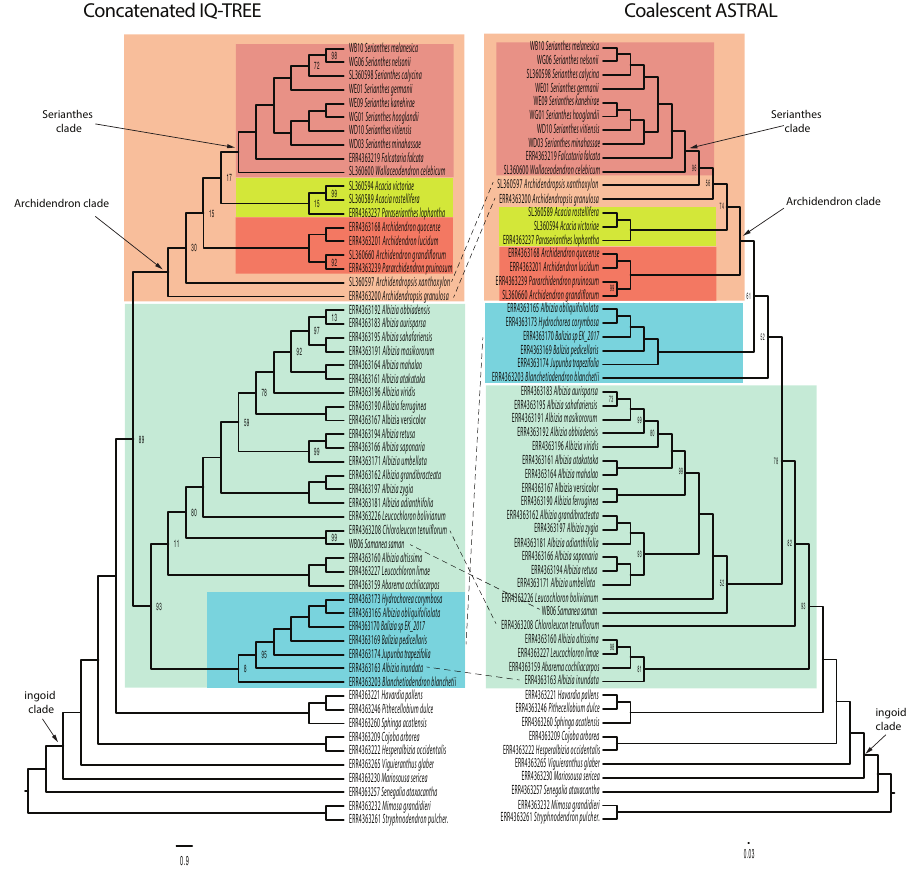
Figure 4. Backbone phylogeny of the ingoid clade. Comparison between the concatenated ML tree (left) and ASTRAL partition tree analysis (right). Bootstrap values < 100% are indicated below the nodes. Major clades in the IQ-tree and phylogenetic grades in the ASTRAL tree are shown in colour blocks with the incongruences between them indicated by dashed